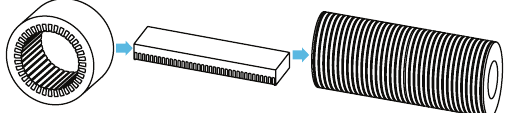
Figure 2: Transformation process between rotary generator and TPMLWG.